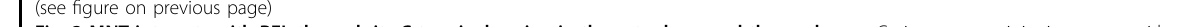
(Fig. 4e, lower panel). The results con fi rmed the repressor effect of MNT on the NF- ĸ B pathway.